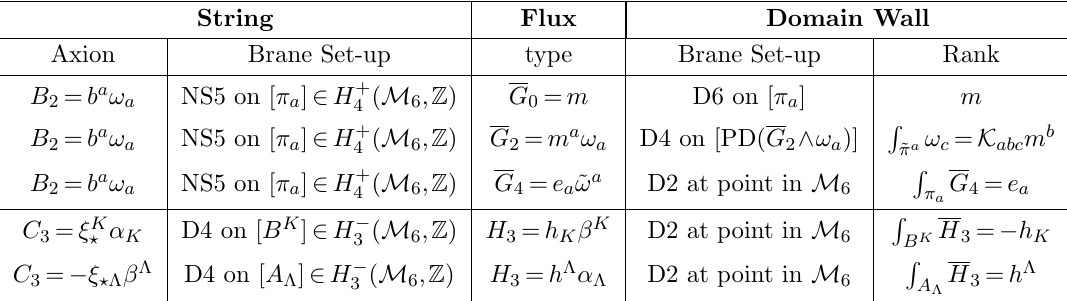
Table 1 . Summary of 4d axionic strings with their respective attached domain walls arising from Dp- and NS5-branes wrapping internal cycles on a Calabi-Yau manifold with internal (cid:13)ux. Non-supersymmetric Minkowski (cid:13)ux